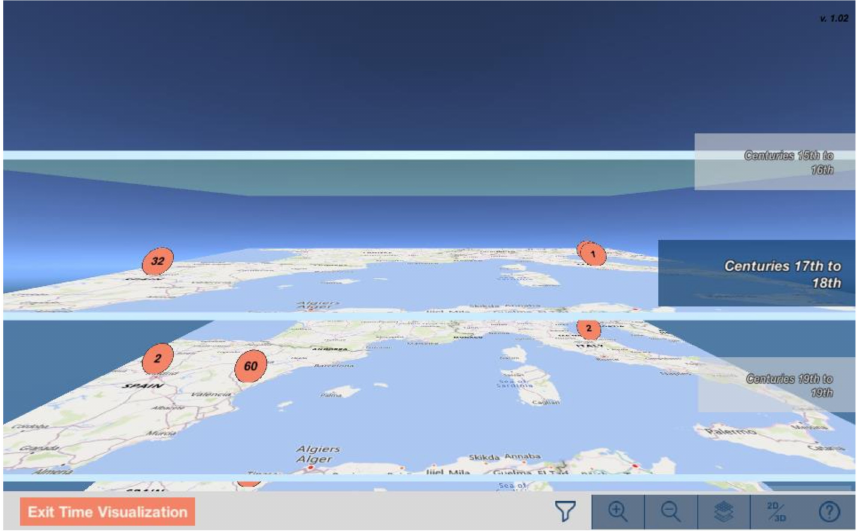
Figure 4. Layered time visualization in STMaps showing data from 17th–18th centuries and from the 19th century. Layered maps always appear in a 3D perspective.